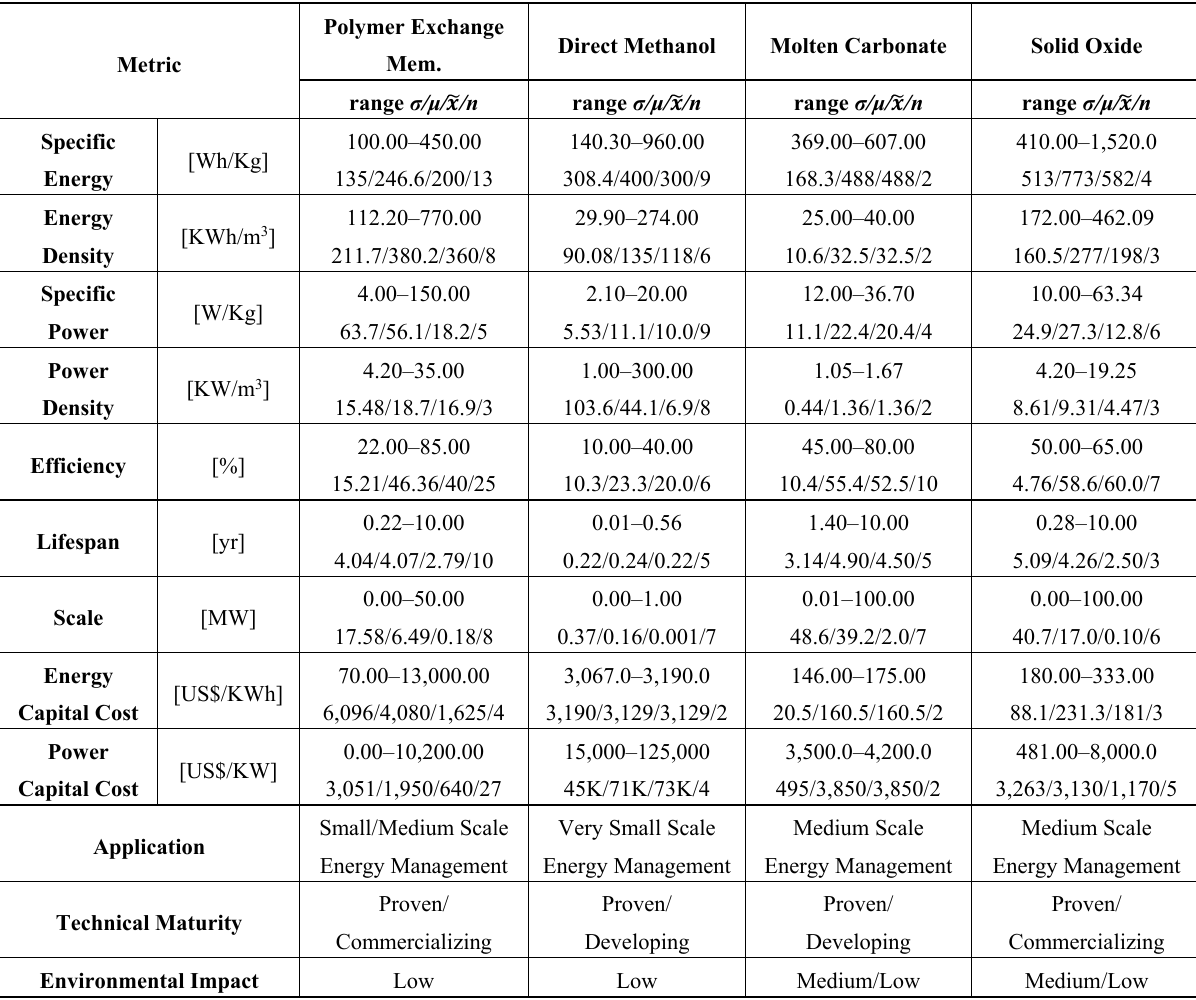
Table 7. Comparing fuel cells (chemical batteries) based on twelve different metrics. Data obtained or calculated from multiple sources